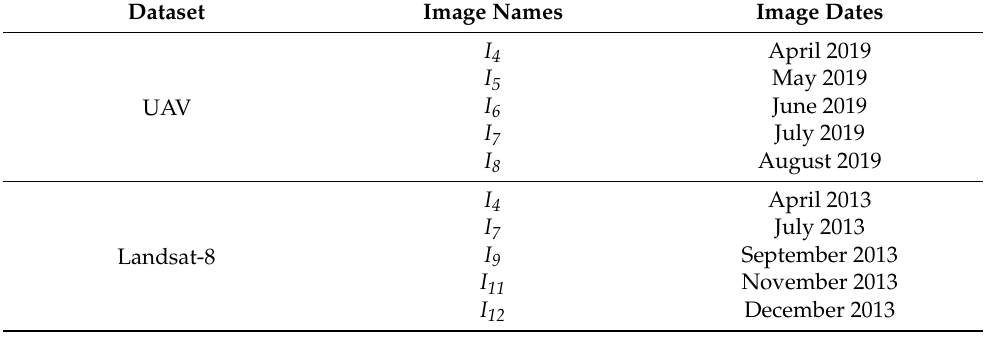
Table 1. Name and date of experimental datasets in first set of experiment.